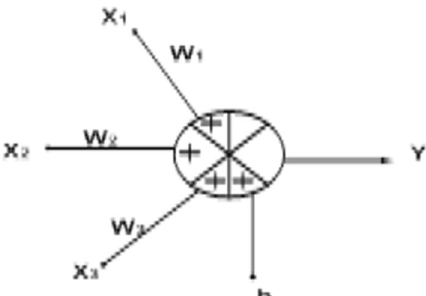
Fig. 3 Structure of the used ANN delay